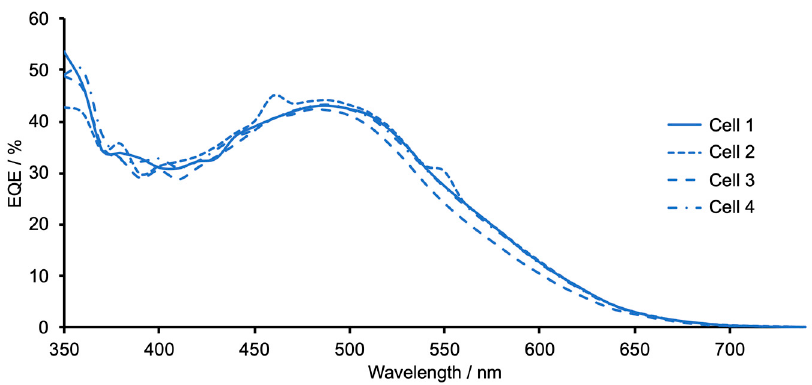
Figure 13. EQE spectra for a set of four DSCs sensitized with [Cu( 5 )( 1 )] + with DPA as a co-adsorbent, measured on the day of sealing the cells.